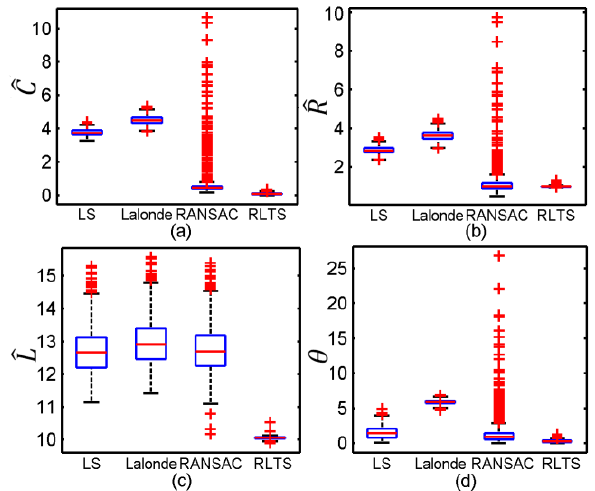
Figure 5. Robustness of the estimates from different cylinder fitting methods; Box plots for performance measures (a) 𝐶̂ , (b) 𝑅 ̂ , (c) 𝐿 ̂ , and (d)